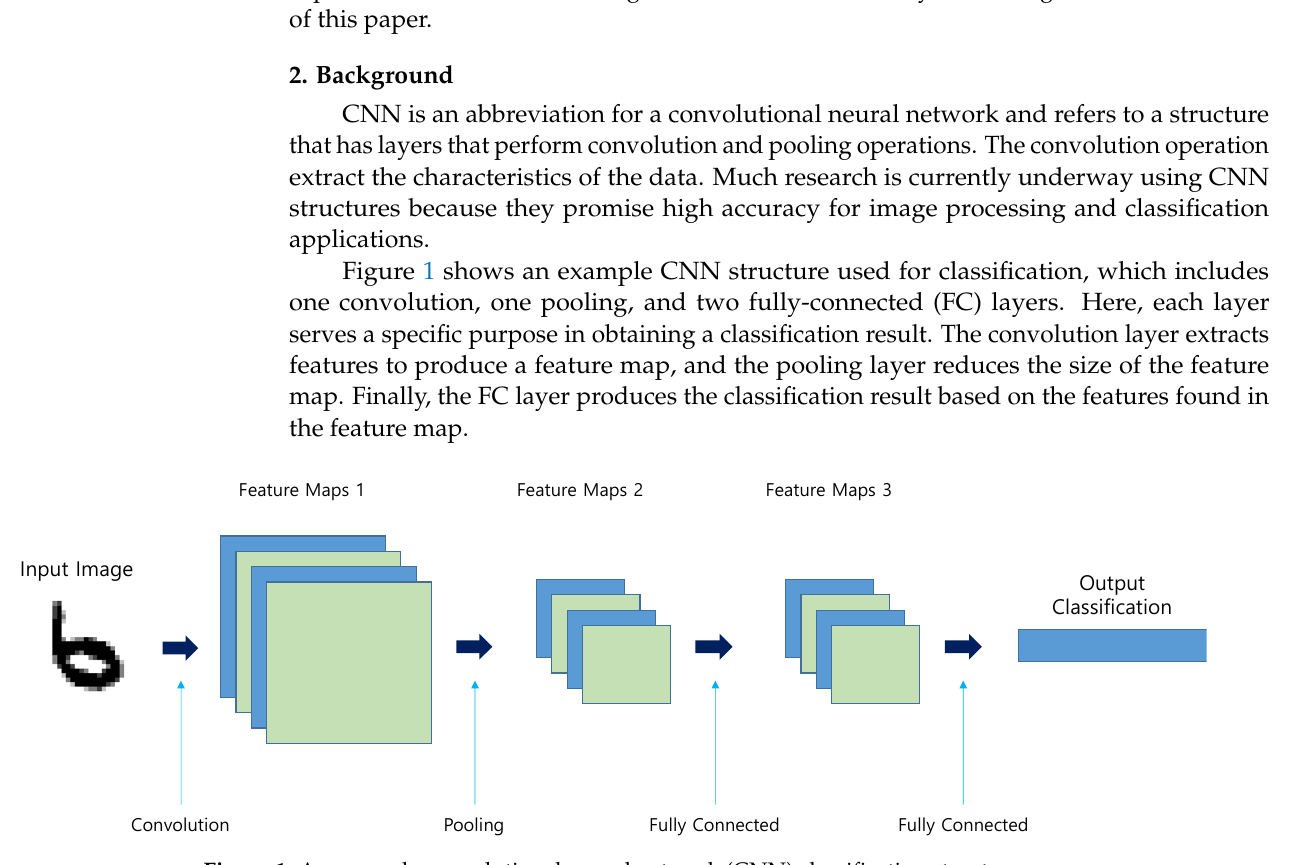
Figure 1. An example convolutional neural network (CNN) classification structure. Our CNN structure targeted the MNIST dataset, with 10 classes representing hand- written digitals of 0–9. Therefore, the output data length was reduced to ten after passing through the two FC layers, which were stored in the output classification memory. Here, each data element of the memory represents the probability of corresponding class among the digits 0–9. The highest value among the ten data elements is most likely the correct answer. If, for example, the seventh value in the memory has the largest value, it is deter- for CNNs, Sections 2.2–2.4 discuss the operation of various layers in CNNs during infer- ence and training, and Section 2.4 discusses the operation of the Softmax activation and cross entropy loss functions in CNNs.